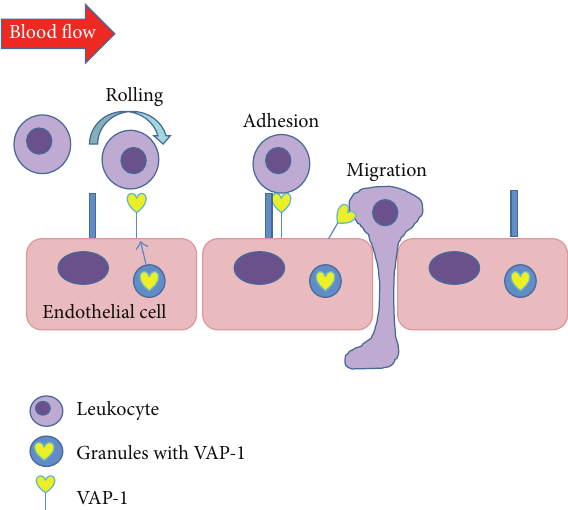
Figure1:Undernormalconditions,VAP-1ismainlyabsentfromthe endothelial cell surface and is stored within intracellular granules, while on inflammation, it is rapidly translocated to the endothelial cell surface and facilitates the recruitment of leukocytes into the in- flamed tissues together with other leukocyte adhesion